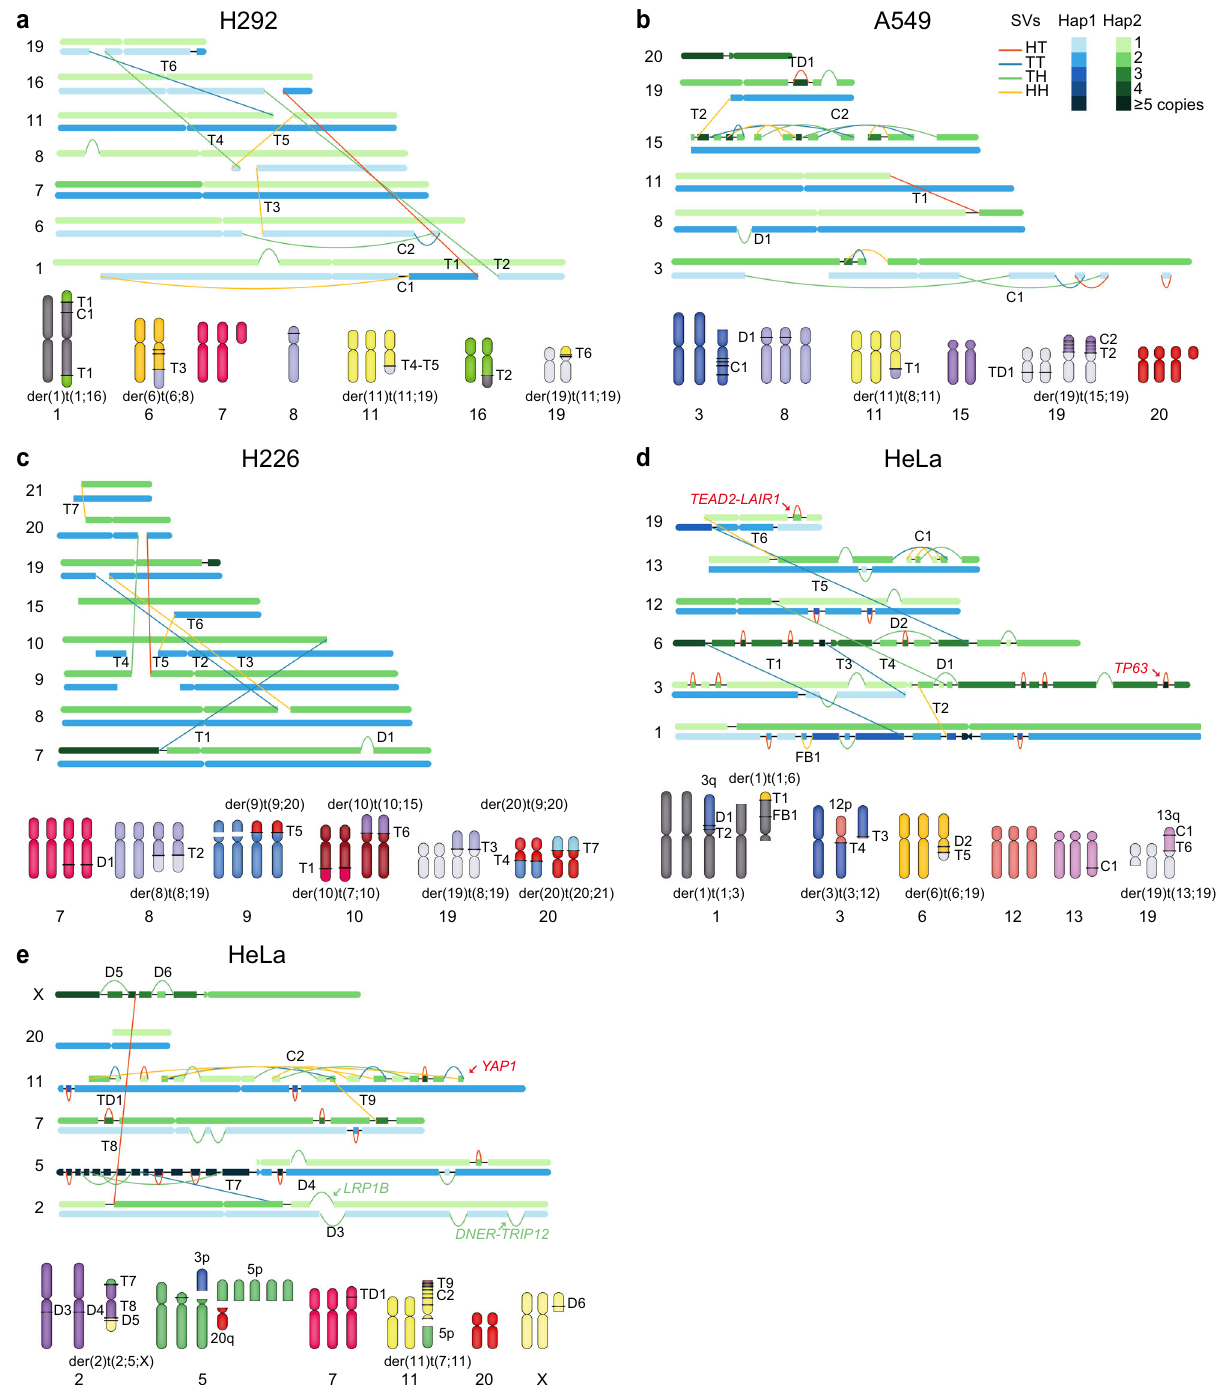
Fig. 3 The haplotype graphs and reconstructed karyotypes of cancer cell lines. The haplotype graph is composed of nodes and segment edges from two haplotypes (green and blue boxes) and reference edges and SV edges (black and coloured lines, respectively). The copy numbers of allelic segments are represented by the colour intensities (one to fi ve copies). SVs included in karyotype analysis are denoted by D (deletion), TD (tandem duplication), T (translocation), FB (fold-back inversion) and C (complex SVs). a – e Sets of interchromosomal SVs across chromosomes and their karyotypes of the H292 ( a ), A549 ( b ), H226 ( c ) and HeLa ( d , e ) cell lines are